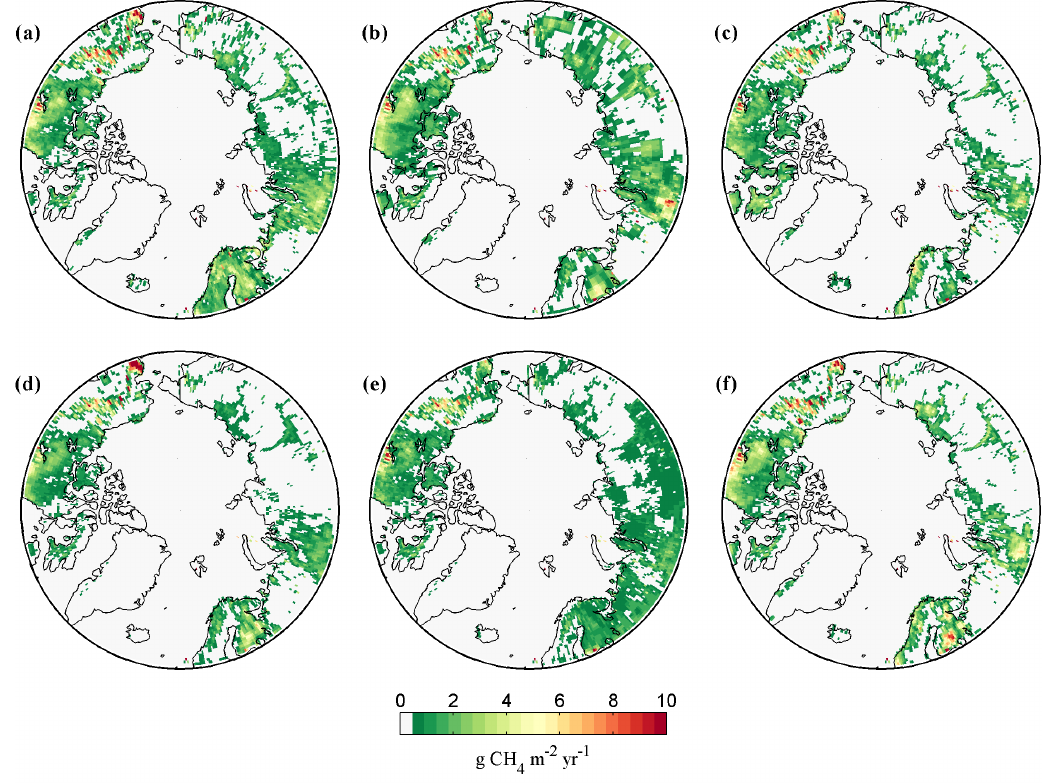
Figure 4. Optimized pan-Arctic CH 4 fluxes in 2005 at 1/2 ◦ × 2/3 ◦ resolution using both SCIAMACHY and NOAA/ESRL observations. (a) BERN; (b) CLM4Me; (c) DLEM; (d) ORCHIDEE; (e) SDGVM; (f)